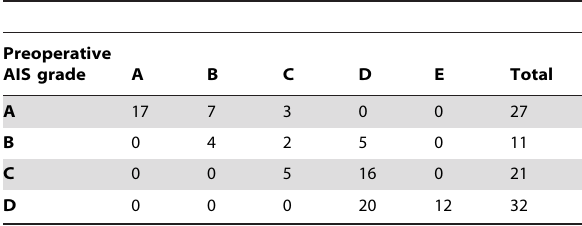
Table 5. Ordinal changes in AIS grade from pre-op to 6 months follow-up: Late Surgery group.